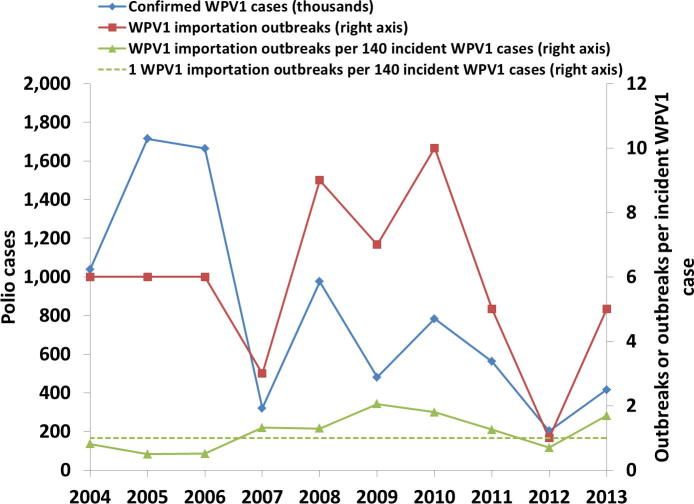
Annual number of confirmed WPV1 cases, WPV1 importation outbreaks into previously polio-free countries, and rate of WPV1 importation outbreaks into previously polio-free countries compared to the average rate over the 10-year time period.